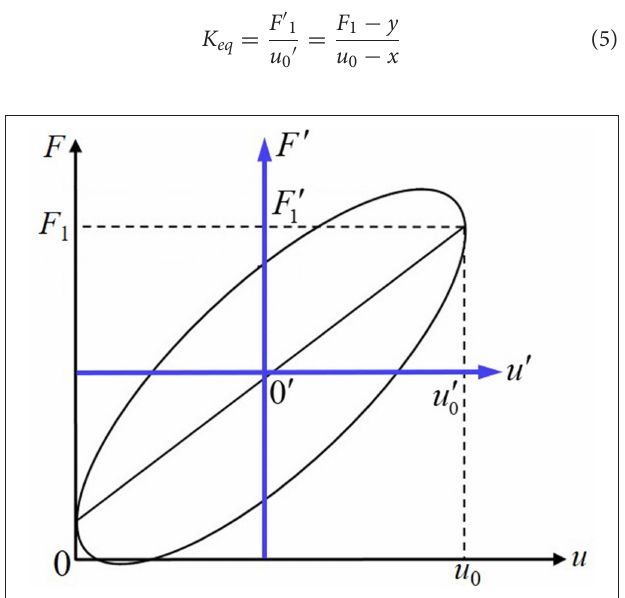
FIGURE 7 | Force-displacement hysteretic curve of viscoelastic materials in local coordinates.